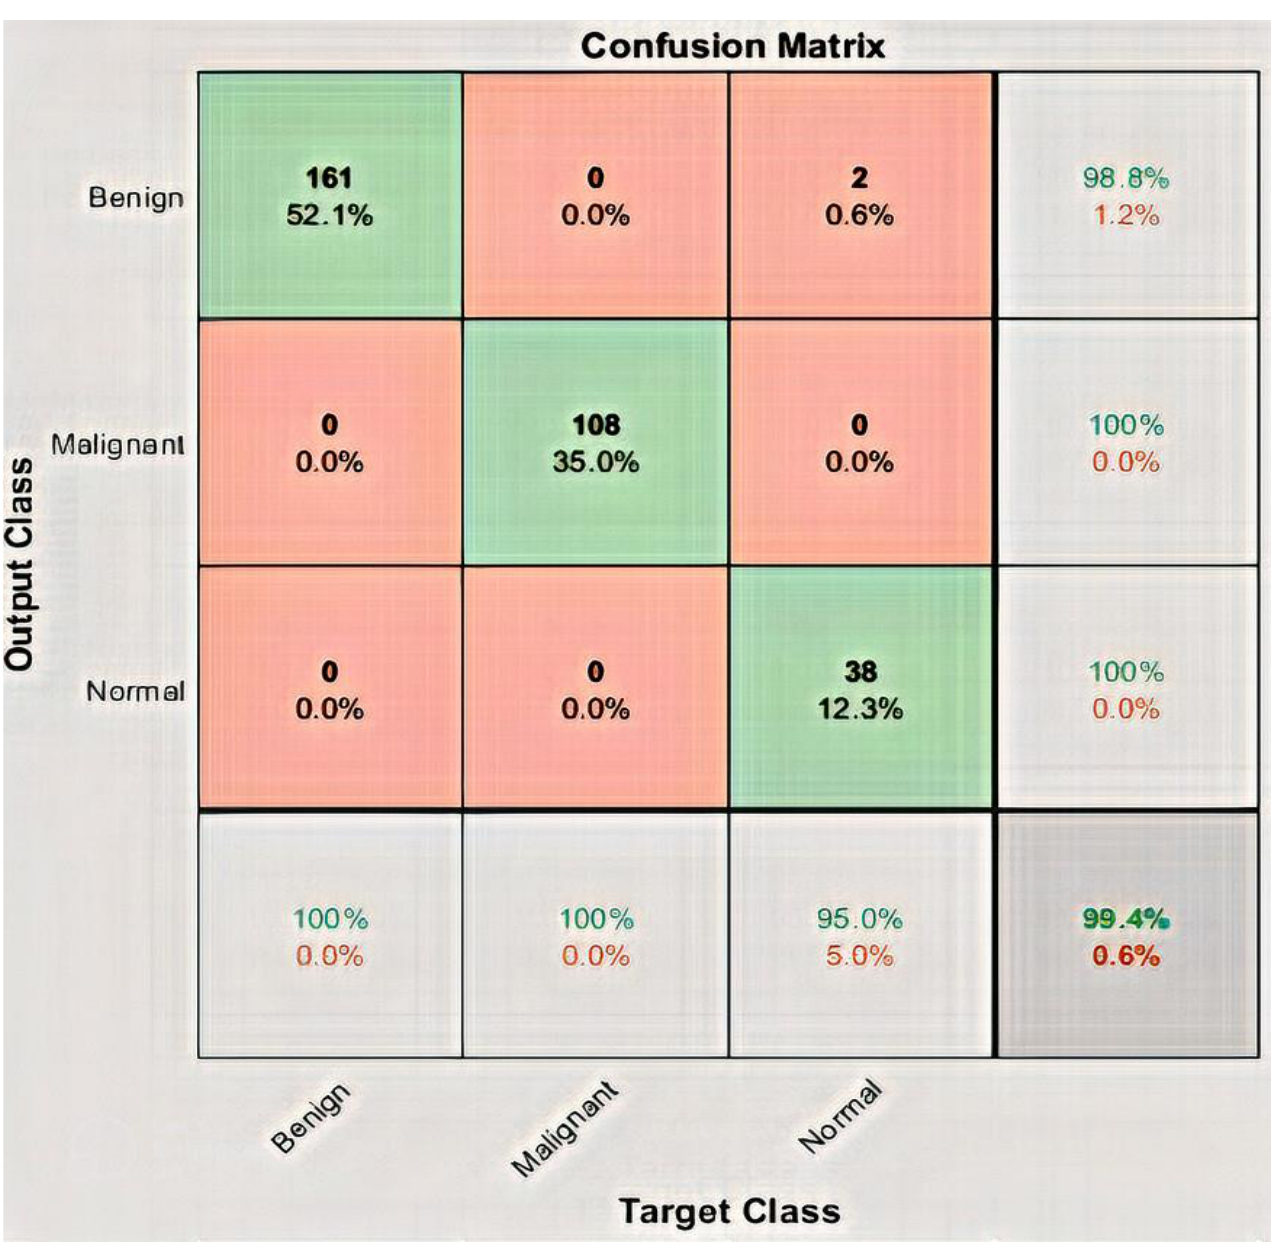
Figure 4. Confusion matrix of DeepBreastCancerNet.